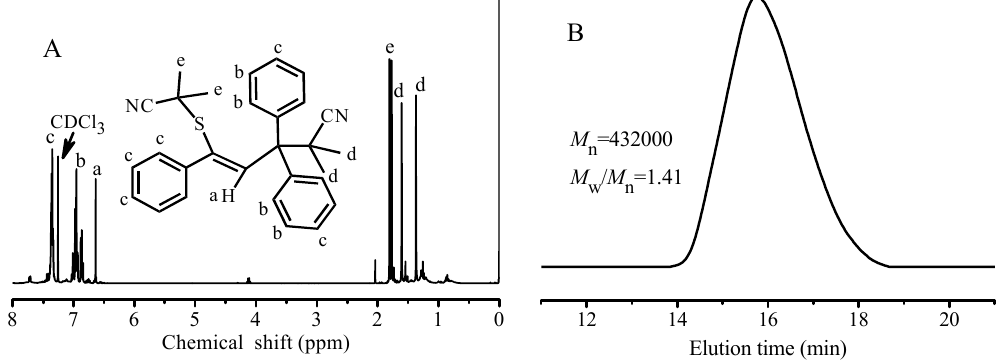
Figure 4. ( A ) 1 H NMR spectrum of the reaction product between AIBN and TPPT, 1,3,3-triphenyl-1-isobutylnitilesulfo-3-isobutylnitrileprop-2-ene; ( B ) GPC curve of the PMMA obtained from the polymerization of MMA using TBBP as initiator with feed molar ratio of MMA/TBBP = 400/1 in anisole (weight ratio of MMA/anisole = 50/50) at 70 °C for 6 h.